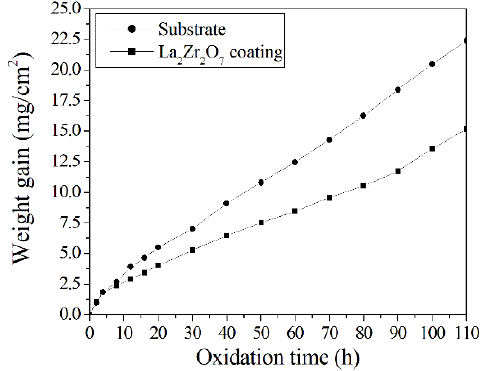
Figure 7. Oxidation weight gain rate of different samples at 1100 °C for different times.